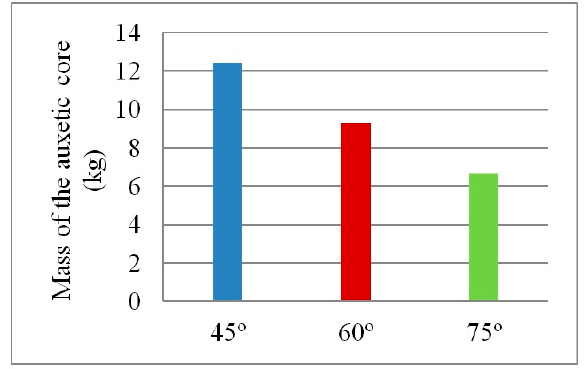
Figure 13. Mass of auxetic cores with 3 different cell angles, and L = 10 mm, t = 2.6mm, t/L = 0.26.